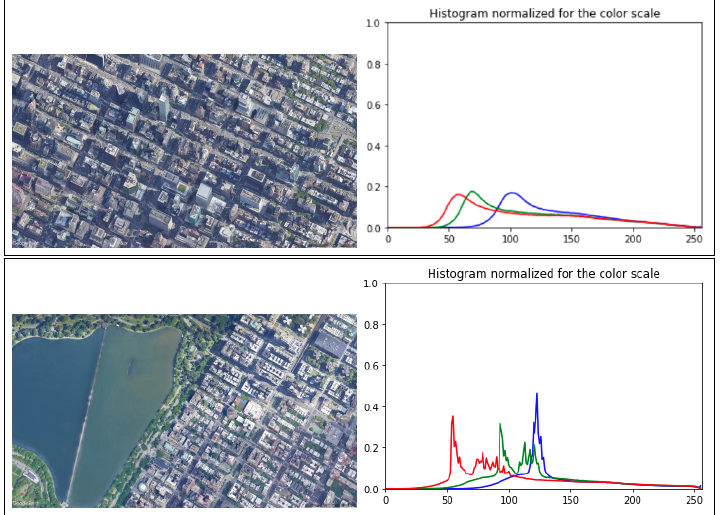
Figure 7. The two types of terrain from an altitude of 1.2 km and histogram graphs: Manhattan as urban ( top ) and Central Park as unsettled open/flat area ( bottom ).